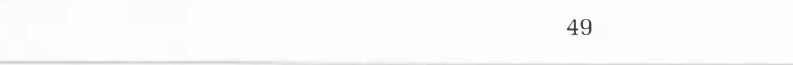
Figure 1 A copper-alloy arrowhead in the AI Ain Museum, Abu Dhabi, United Arab Emirates, covered in copper corrosion. The tip of the arrowhead is undergoing active copper-chloride